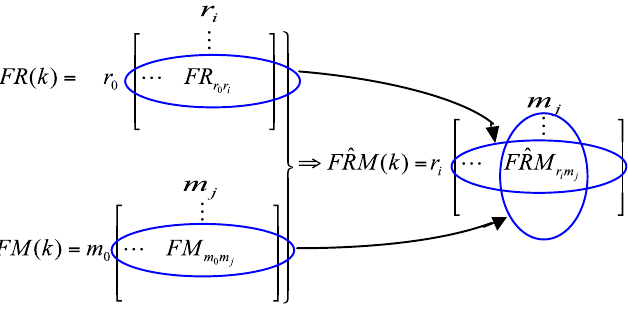
Figure 1. The ways that the matrix is determined [from Sadeghian and Jalali-Naini